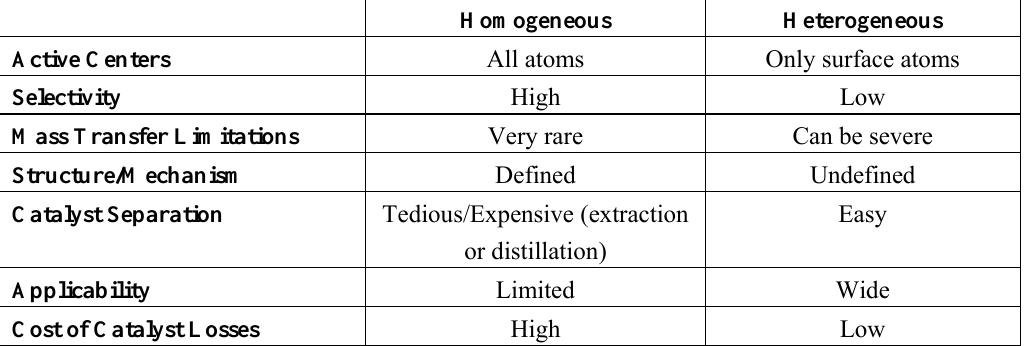
Table 1. Comparison between Homogeneous and Heterogeneous